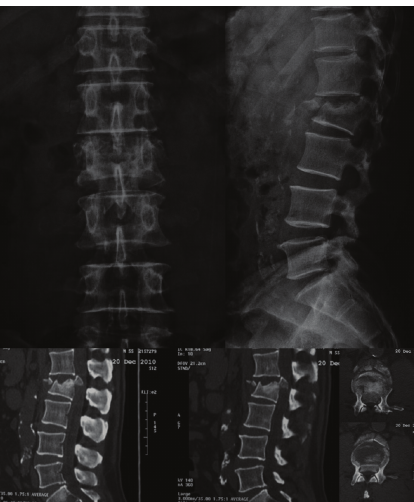
Figure 1: X-ray and CT scan showing a burst fracture on L2 vertebra with a fragment inside the spinal canal.